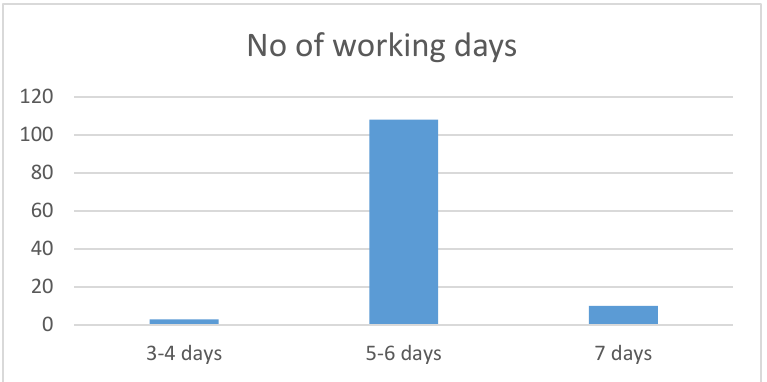
Figure 3. Number of working days of waste pickers in Lagos State. Source: Computed by authors. Table 3. Number of Working Hours of Waste Pickers in Lagos State,